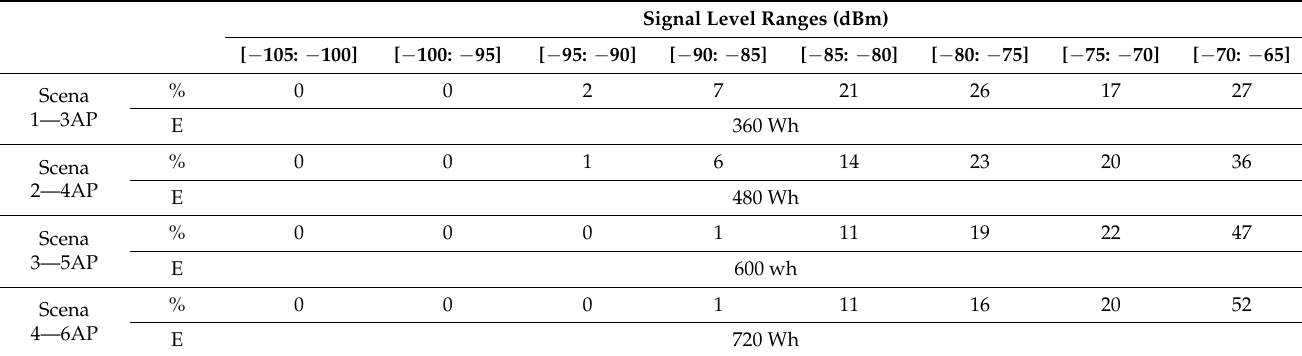
Table 4. Simulation results of the four scenarios in terms of coverage (%) and energy demand (E) are provided for different scenarios and signal